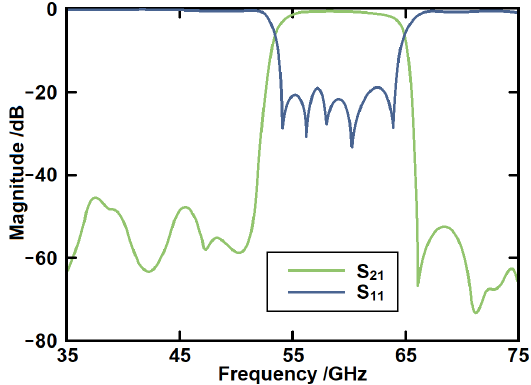
Figure 7. The simulated S -parameters of the high-order SSPP structure.